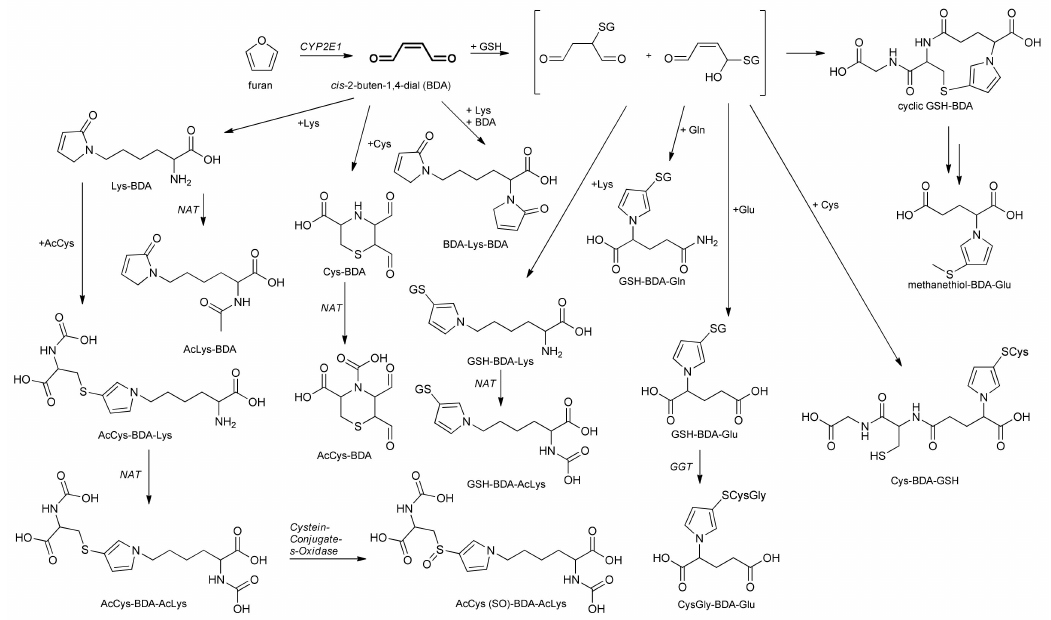
Figure 10. Proposed metabolic pathways for furan based on metabolites identified by UPLC-qToF-MS / MS in samples of urine from human participants after consumption of a bolus of co ff ee brew and previously identified pathways [19].